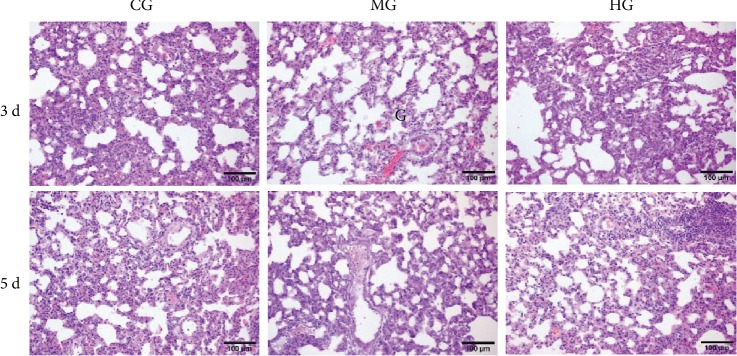
HE staining analysis of the severity of lung injury. All mice were allocated into three groups: CG (wild group), MG (pancreatitis-induced lung injury model group), and HG (hydrostatin-SN10-treated model group). n = 12 for each group.